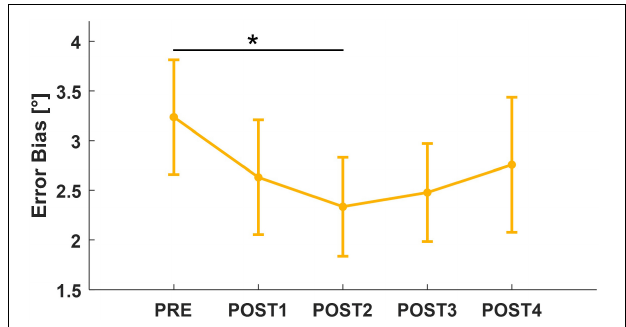
FIGURE 6 | Mean and standard error for Error Bias, computed considering the first six trials of each assessment. After post-hoc analysis, significant results ( p < 0.05) were marked with